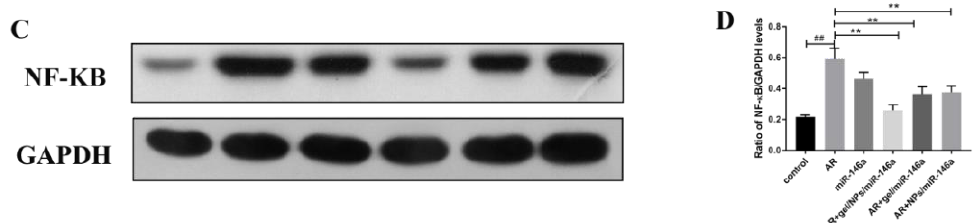
Figure 8. The protein bands of TLR4 ( A , B ) and NF-KB ( C , D ) normalized to GAPDH in nasal mucosa determined by Western blot analysis. Data represent the mean ± SD of three independent experiments. ## p < 0.01 compared with the control group; ** p < 0.01 compared with the AR group.